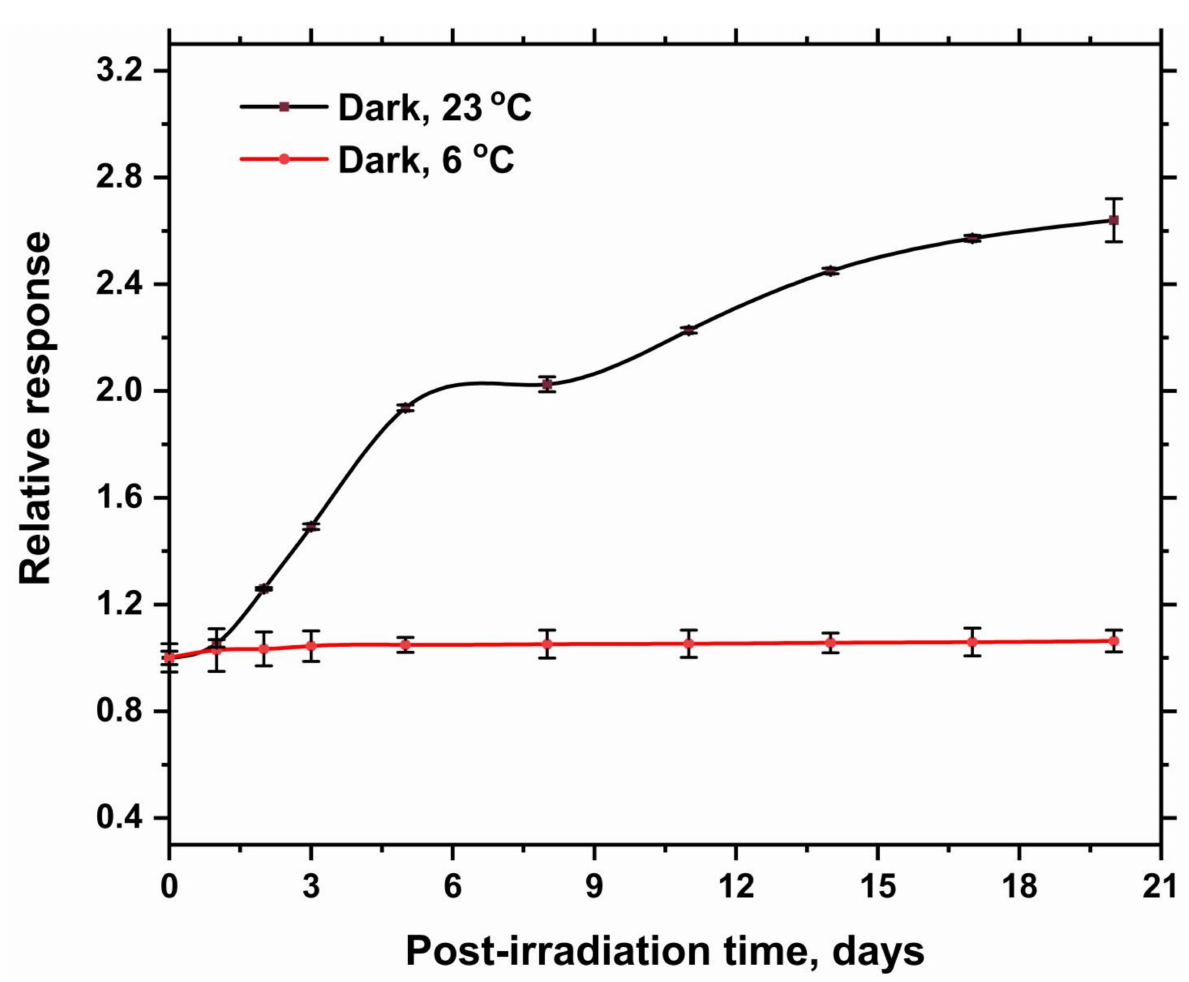
Figure 9. Relative response of irradiated hydrogel dosimeter (100 mM AgNO 3 and 15% Glycerol) to the response measured immediately after irradiation (zero time) as a function of storage time (days). The hydrogel dosimeters were irradiated at 50 Gy and then stored in a dark place at different temperatures (6 ◦ C and RT, 23 ◦ C). The solid lines are a guide for the eye obtained using a basis spline function. Table 4. The silver nitrate (100 mM) PAC hydrogel composition without and with 15% glycerol. Fraction by Weight Fraction by Symbol Z Number (without Glycerol)